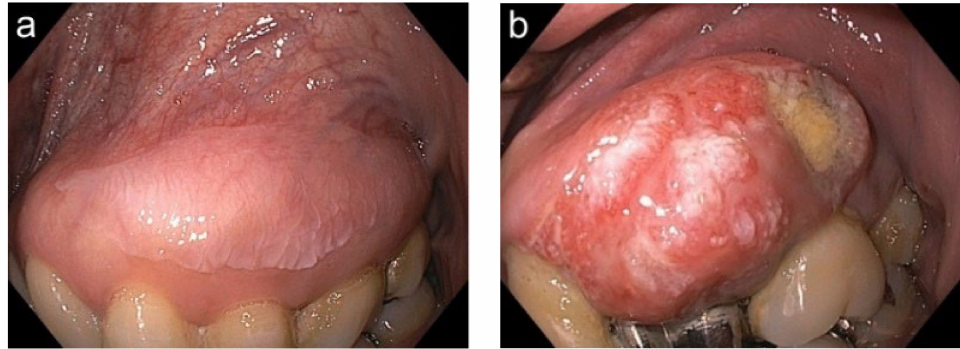
Figure 3. Presentation of a typical homogeneous lesion ( a ), and non-homogeneous lesion ( b